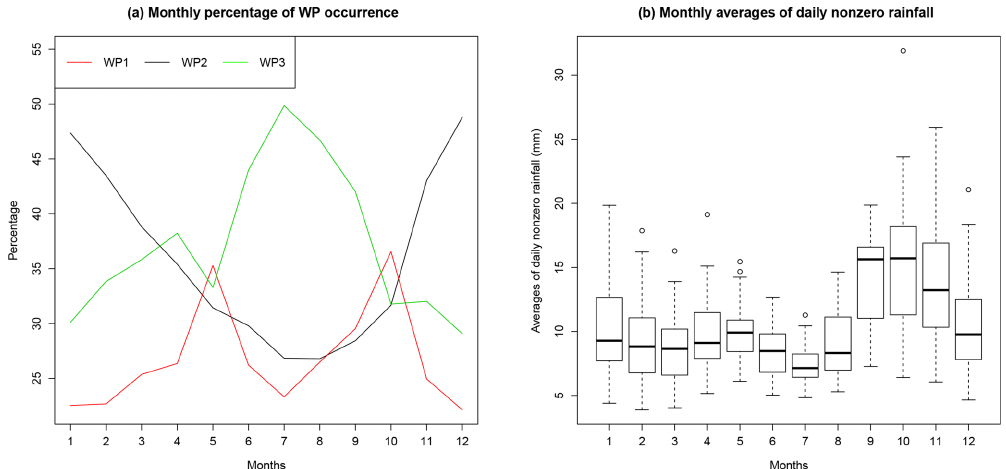
Figure 4. (a) Monthly percentage of occurrence of the three WPs. (b) Boxplot of the monthly averages of daily nonzero rainfall. Each boxplot contains 42 points (one point per